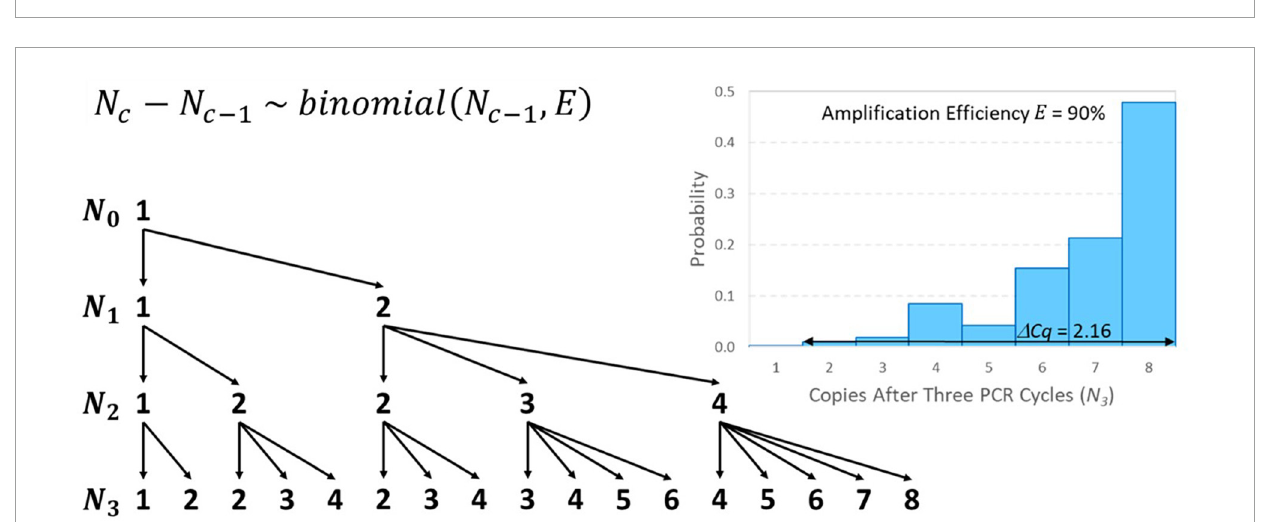
FIGURE4 Tree diagram illustrating all possible outcomes of amplifying N 0 = 1 target gene through three PCR cycles and a distribution of resulting numbers of amplicons after three cycles with E = 90% amplification efficiency. The conditional probability associated with each arrow may be calculated using the binomial distribution shown. In terms of 1.9-fold amplification, the difference between having 2 or 8 amplicons after three cycles is 2.16 Cq on